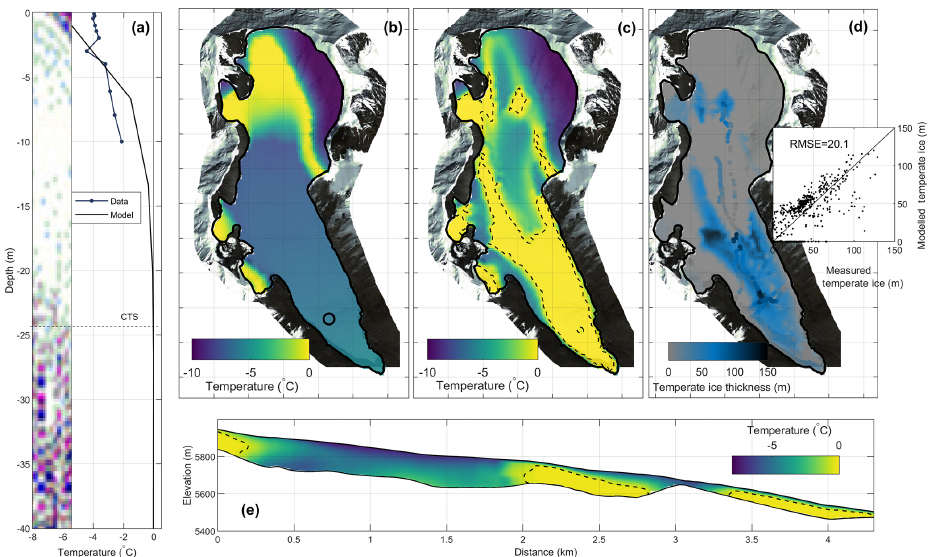
Figure 10. Modelled thermal regime after a 40-year transient run forced by mean climatic condition over the period 1981–2016 (see Fig. 3b). (a) Modelled and measured mean temperature profile (2014/2015) in the ablation zone (black circle in b ). The inset shows the radar measure- ment next to the thermistor (black circle in b ) with the dashed line showing the modelled cold–temperate transition surface (CTS). (b) Mean surface boundary condition over the period 1981–2016. (c) Modelled basal temperature. (d) Distribution of modelled and measured temperate ice thickness. (e) Modelled temperature along the radar longitudinal section presented in Fig. 2.